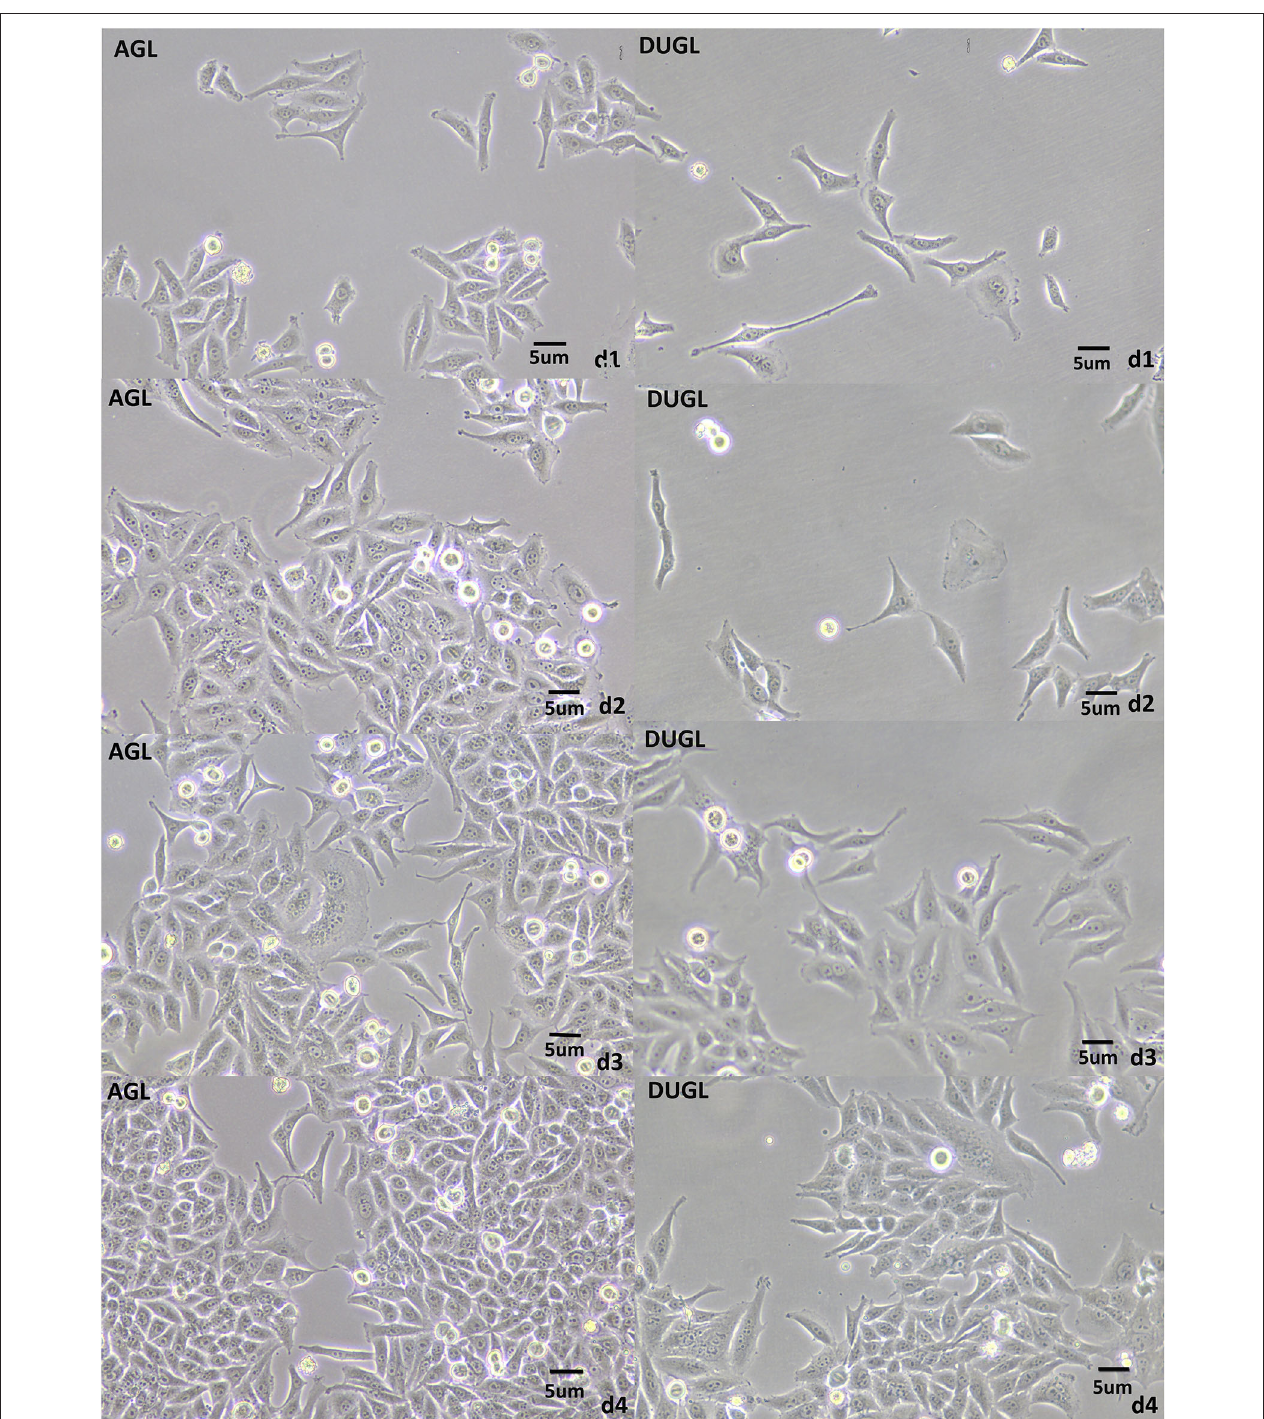
FIGURE 2 | FD-LSC-1 cells cultured for 4 days in the DUGL or AGL observed using light microscopy (at 10 × magnification). AGL, above-ground laboratory; DUGL, deep underground laboratory. The cell density in the DUGL group was observably lower than that in the AGL group on the corresponding day.